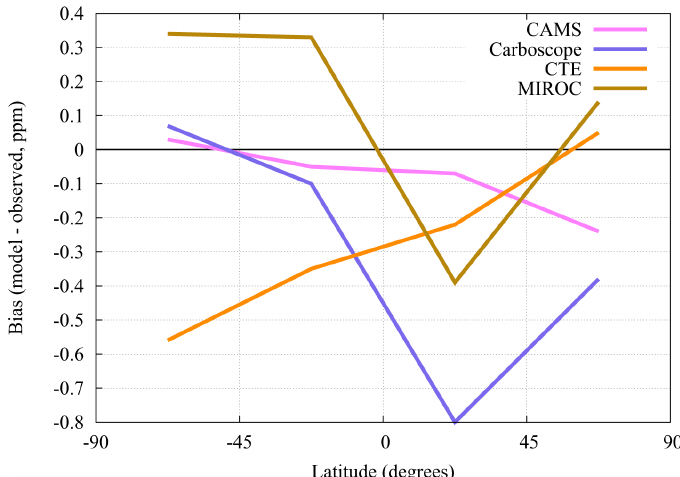
Figure B3. Evaluation of the atmospheric inversion products. The mean of the absolute model minus observations is shown for four latitude bands. The four models are compared to independent CO 2 measurements made onboard aircraft over many places of the world between 1 and 7km above sea level. All data between 2008 and 2016 archived in the Cooperative Global Atmospheric Data Integration Project (CGADIP, 2017) have been used to compute the biases of the differences in four 45 ◦ latitude bins. Land and ocean data are used without distinction. The number of data for each latitude band is 16000 (90–45 ◦ S), 53000 (45 ◦ S–0), 64000 (0–45 ◦ N), and 122000 (45–90 ◦ N), rounded off to the nearest